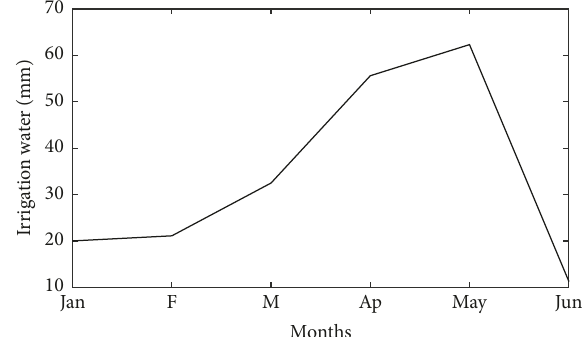
Figure 5: Monthly difference of estimated and usual irrigation water.